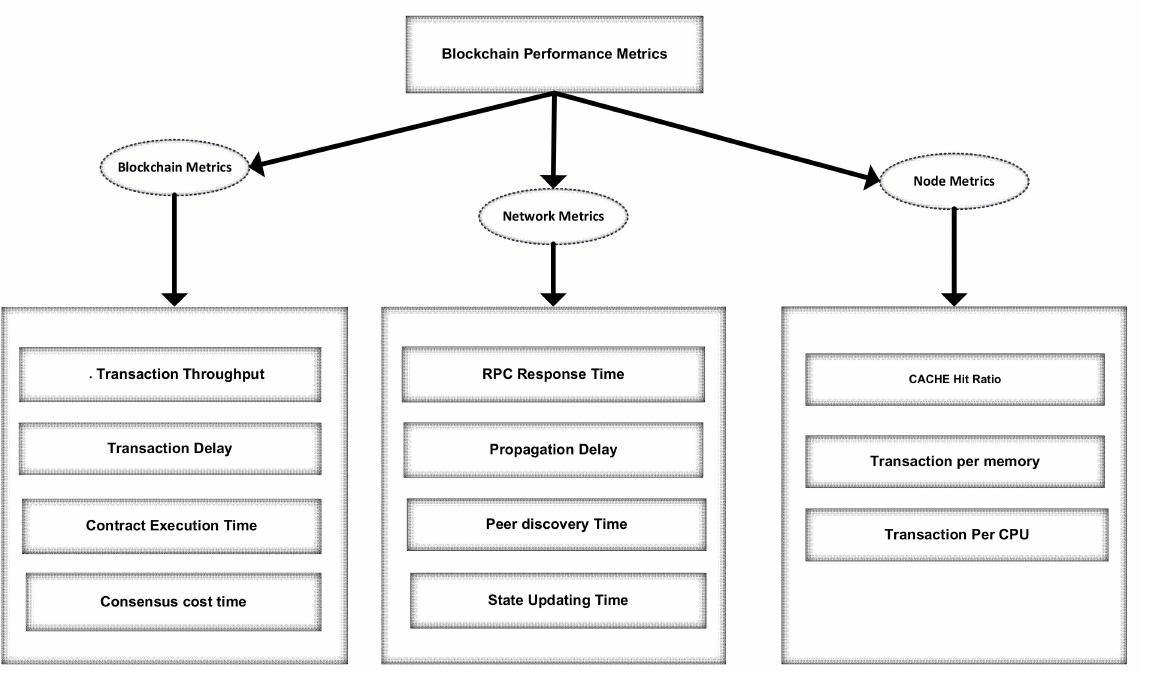
Figure 3. Performance metrics used for BC applications